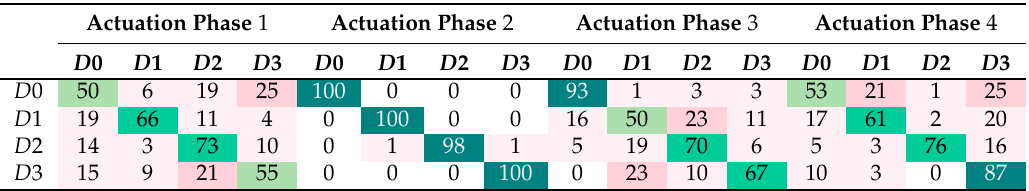
Table 7. Confusion matrix of the application of the t -SNE based damage detection and classification procedure presented in Sections 3 and 4 to the case of the aluminum plate in textbfScenario 3, in the time domain . Rows represent true values, while columns represent predicted